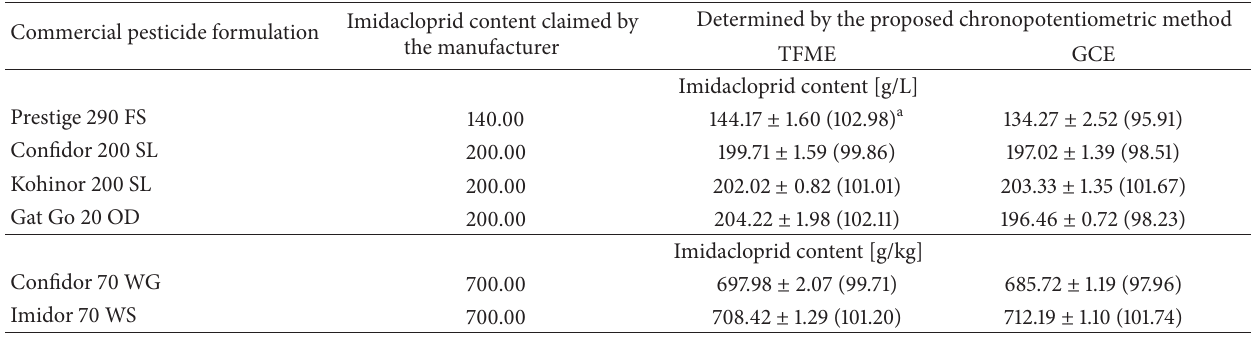
Table 3: Results obtained for the analysis of commercial formulations by the proposed chronopotentiometric method.